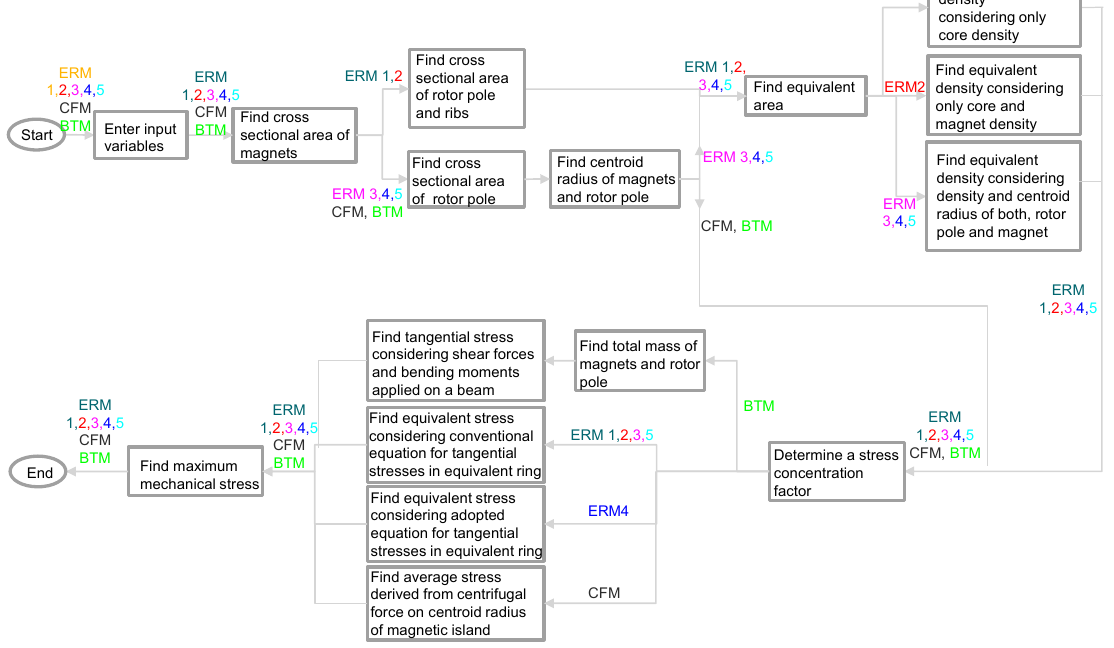
Figure 3. Methodology flow diagram of ERM1 to ERM5, CFM and BTM and general differences in the approaches.